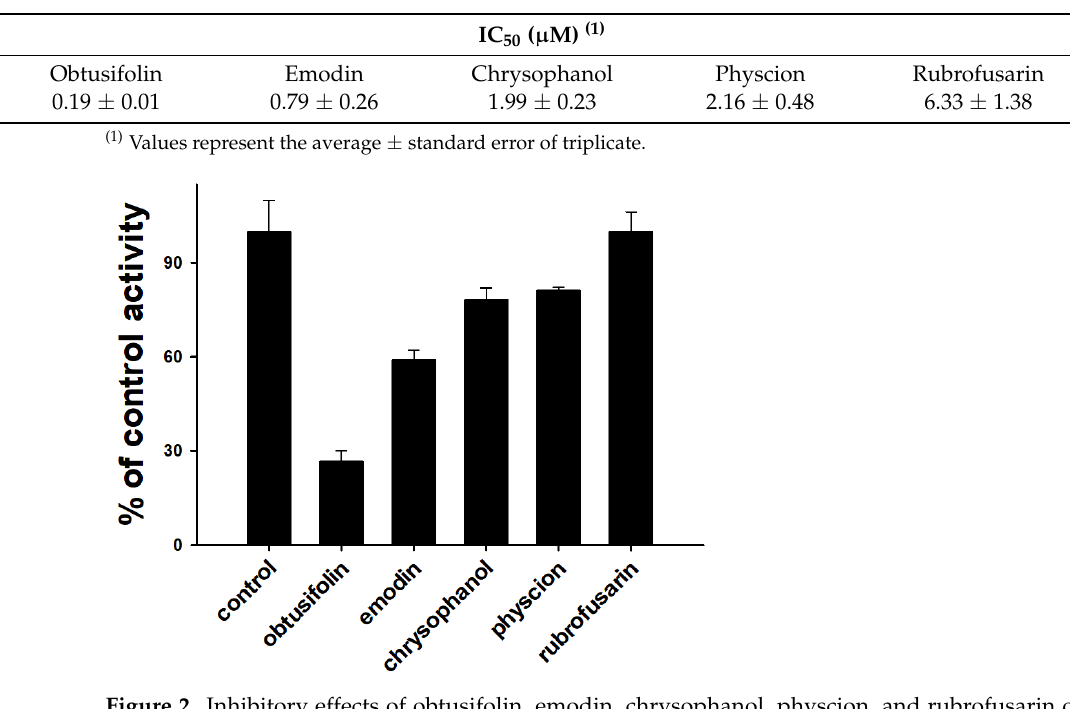
Table 1. Inhibitory effects of four anthraquinones (obtusifolin, emodin, chrysophanol, and physcion) and one naphthopyrone (rubrofusarin) against CYP1A2-mediated phenacetin O -deethylase activity in human liver microsomes.